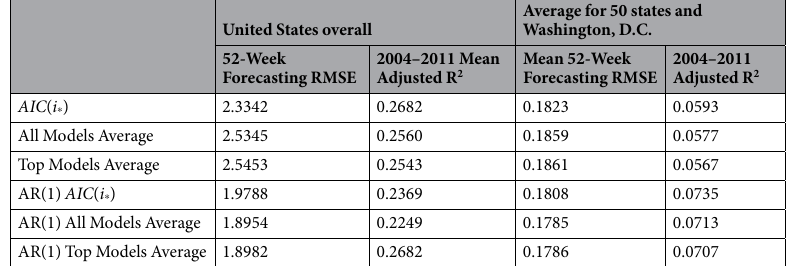
): lowest AIC model, All *